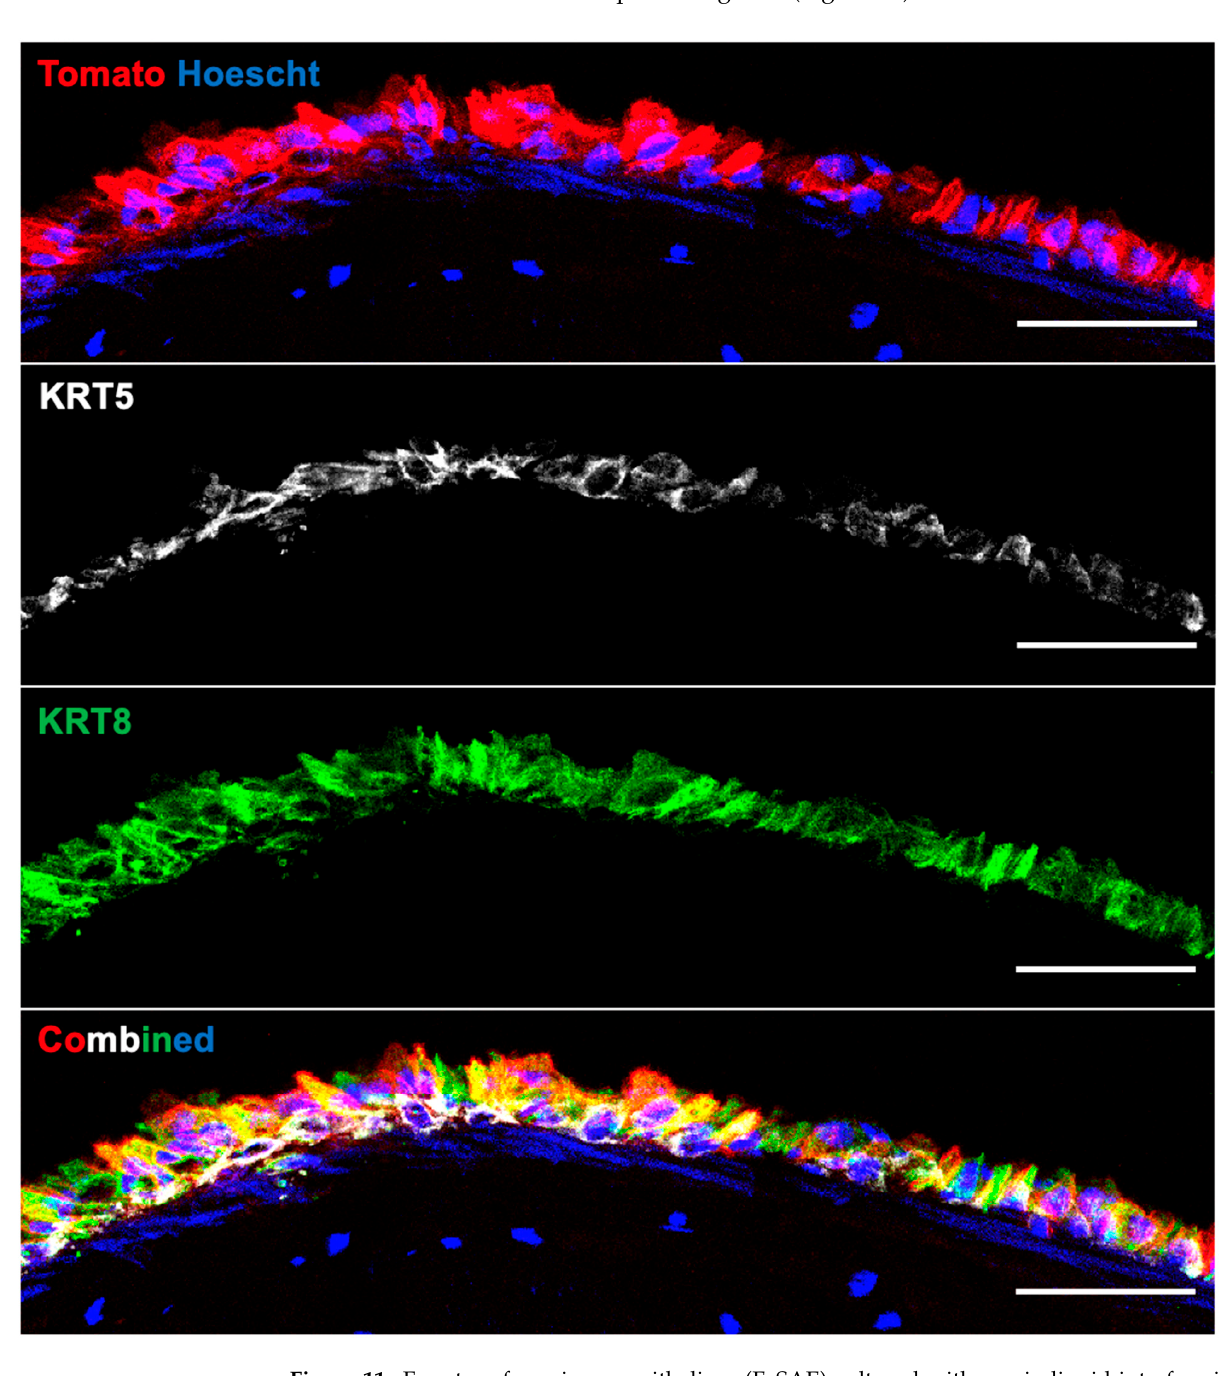
Figure 11. Ferret surface airway epithelium (FeSAE) cultured with an air–liquid interface in the bi ‐ oreactor on Day 12. Tomato cells were expanded for 4 days and then cultured on an air–liquid in ‐ terface by syringe ‐ pumping humidified air. There was a clear distinction between cells that retained a Keratin 5 basal cell identity and those that expressed Keratin 8, which indicates commitment to a luminally differentiated cell. There was no expression of cilia or mucin at this early time